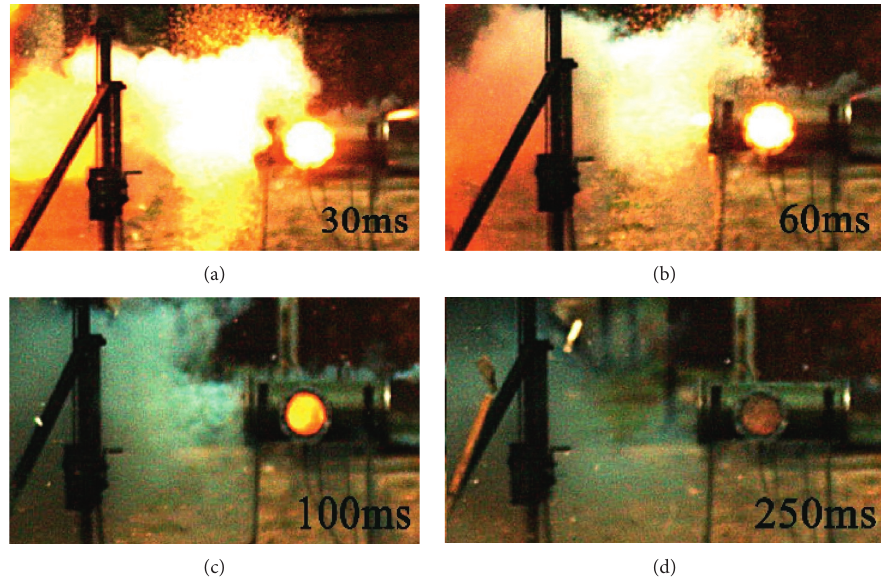
Figure 14: Energy release phenomenon of impacting a 4 mm steel plate with the Al/PTFE/W jets with a 45% W content.